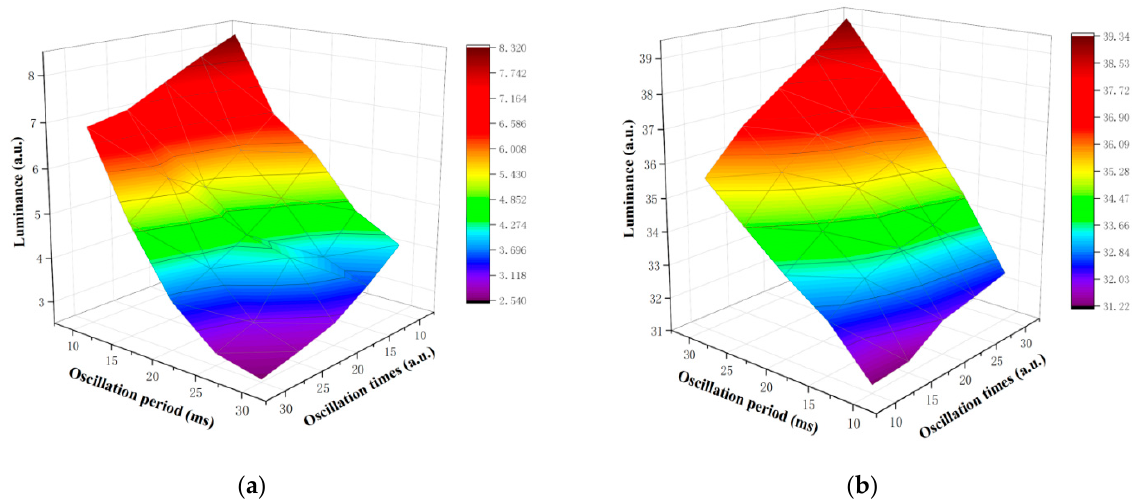
Figure 6. The erasing stage and the white or black driving stage were set to 20 ms and the high frequency oscillation voltage value was set to ±5 V. ( a ) The influence of oscillation period and oscillation times in luminance when the target grayscale was black. ( b ) The influence of oscillation period and oscillation times in luminance when the target grayscale was white.